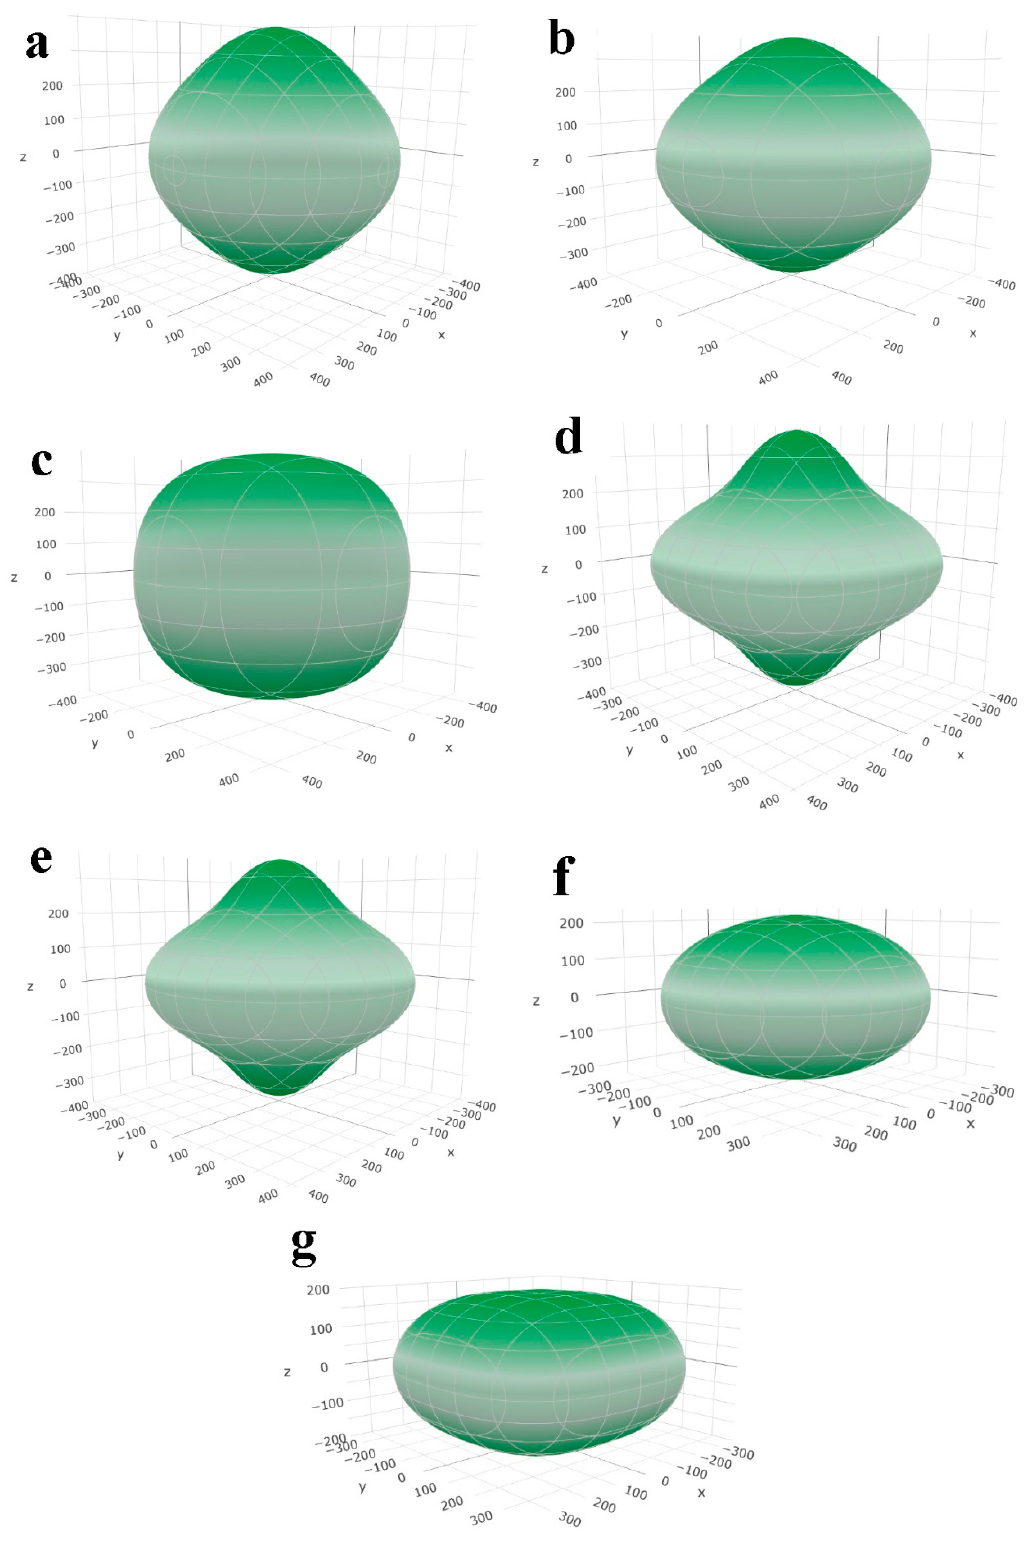
Figure 4. Surface constructions of Young’s modulus of M 7 C 3 carbides: ( a ) Fe 5 Cr 2 C 3 ; ( b ) Fe 3 Cr 4 C 3 ; ( c ) Fe 2 Cr 5 C 3 ; ( d )Fe 3 Cr 3.5 W 0.5 C 3 ; ( e ) Fe 3 Cr 3 W 1 C 3 ; ( f ) Fe 3 Cr 2.5 W 1.5 C 3 ; ( g ) Fe 3 Cr 2 W 2 C 3 .